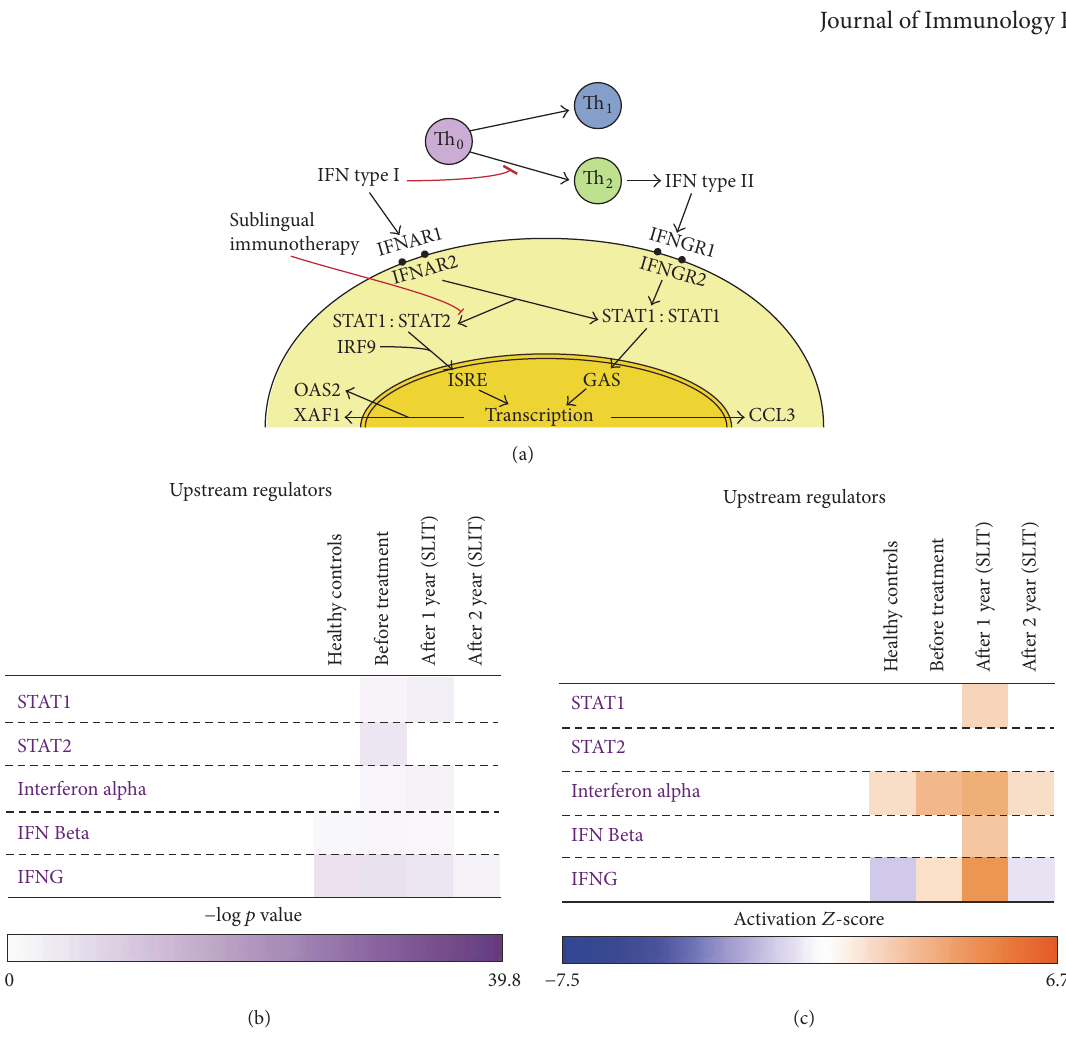
Figure 2: Sublingual immunotherapy causes complex changes of the key genes of the interferon pathway. (a) The diagrammatic sketch of potential involvement of type I interferons in T cell differentiation and sublingual immunotherapy. (b) The comparison of expression of upstream regulators, STAT1, STAT2 , IFN 𝛼 , IFN 𝛽 , and IFNG, in the diluent- and allergen-challenged cells of healthy controls and patients before treatment, after one year of SLIT, and after two years SLIT. Results are presented as –log ( 𝑝 value). The 𝑝 value comes from the Fisher exact test done between the different comparisons for that particular gene significance. (c) The activation Z -score of expression of upstream regulators, STAT1, STAT2 , IFN 𝛼 , IFN 𝛽 , and IFNG, in the diluent- and allergen-challenged cells of healthy controls and patients before treatment, after one year of SLIT, and after two years of